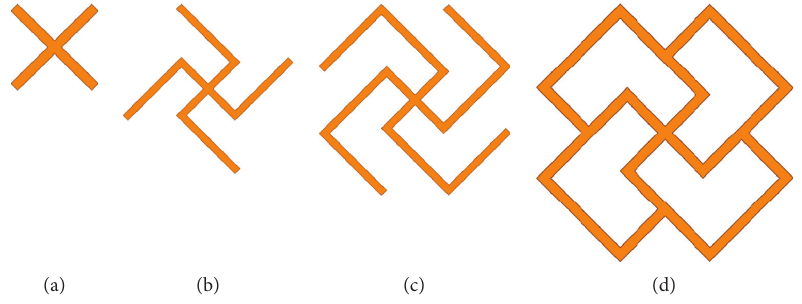
Figure 4: Diagram of the antenna radiator generation process.